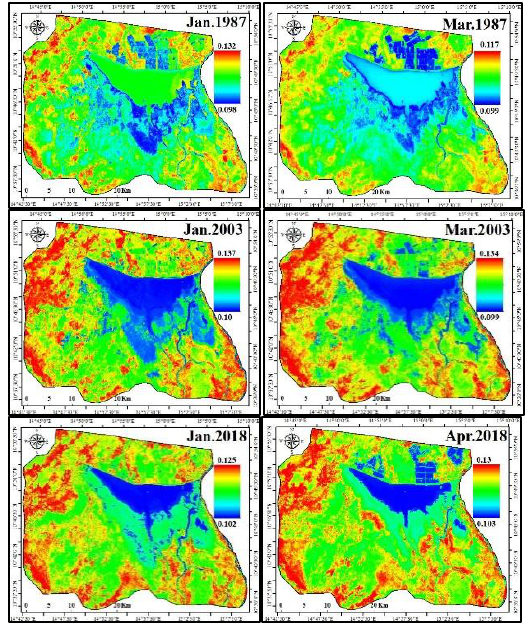
Figure 10. Visual patterns of the LSGDI2